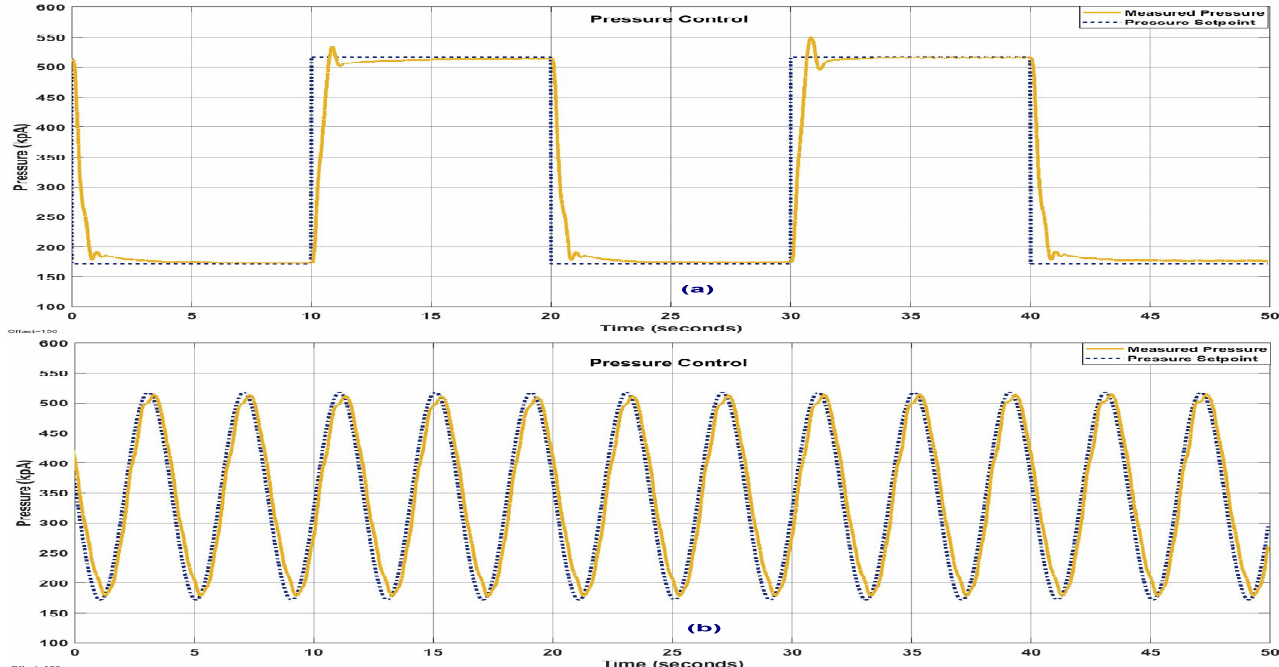
Figure 13. Pressure loop PID responses after tuning: ( a ) step response and ( b ) 0.25 Hz sinusoidal reference.